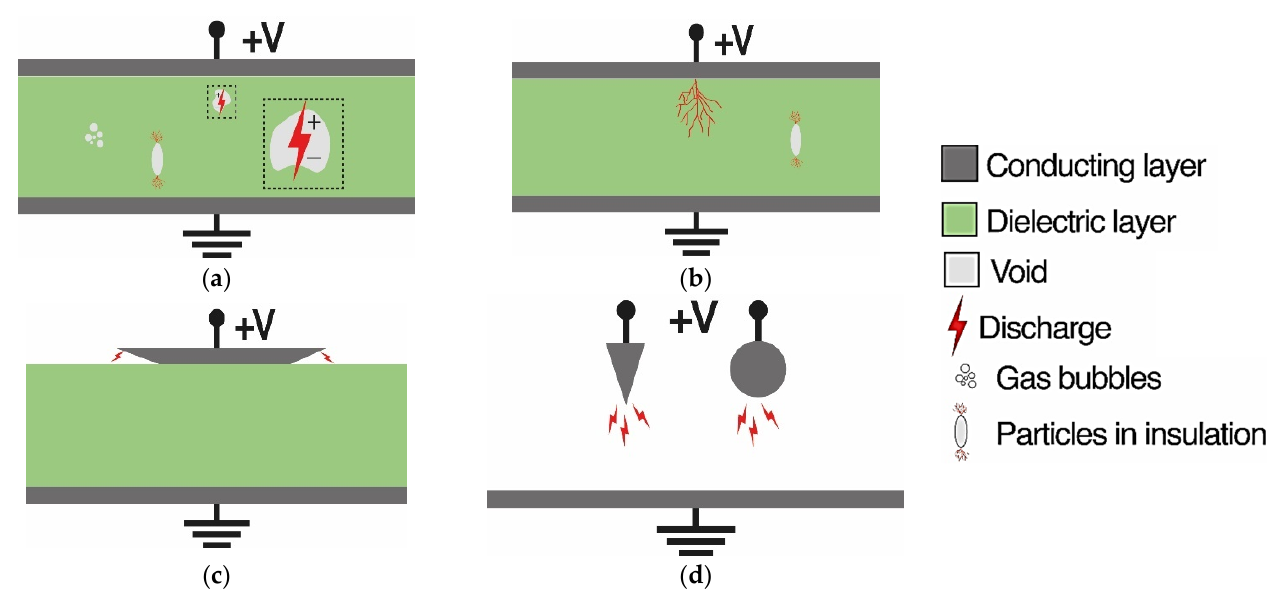
Figure 1. Different types of partial discharges: ( a ) internal, ( b ) treeing, ( c ) surface, and ( d ) corona.